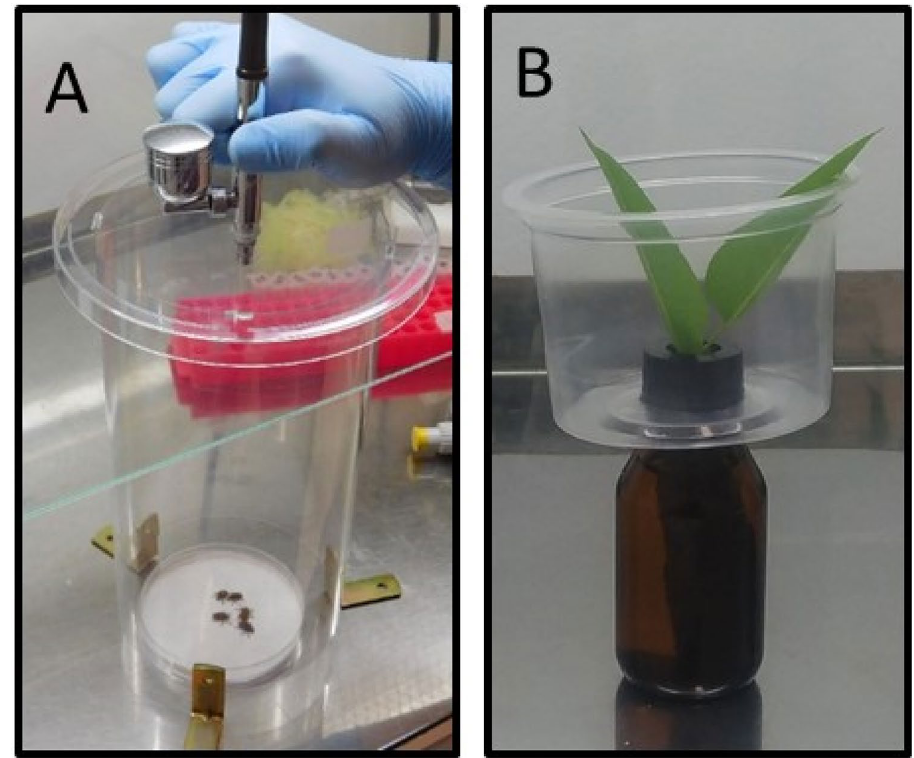
Figure 5. Detail of the experiment set up for screening fungal strains against adults of G. platensis under laboratory conditions. ( A ) Portable mini-sprayer assembled with a dual-gravity airbrush, modified from Mascarin et al. (2013), operated with 10 PSI and loaded with 127 µL of fungal suspension for application onto G. platensis beetles. Acrylic cylinder measured 11.5 cm in diameter and 23 cm in height. The triplet created a free space of 2 cm to allow depressurization during spraying. ( B ) Experimental unit consisting of eucalyptus leaf with its petiole immersed in a glass vial filled with water to keep its turgor and serving to feed the beetles confined in a plastic